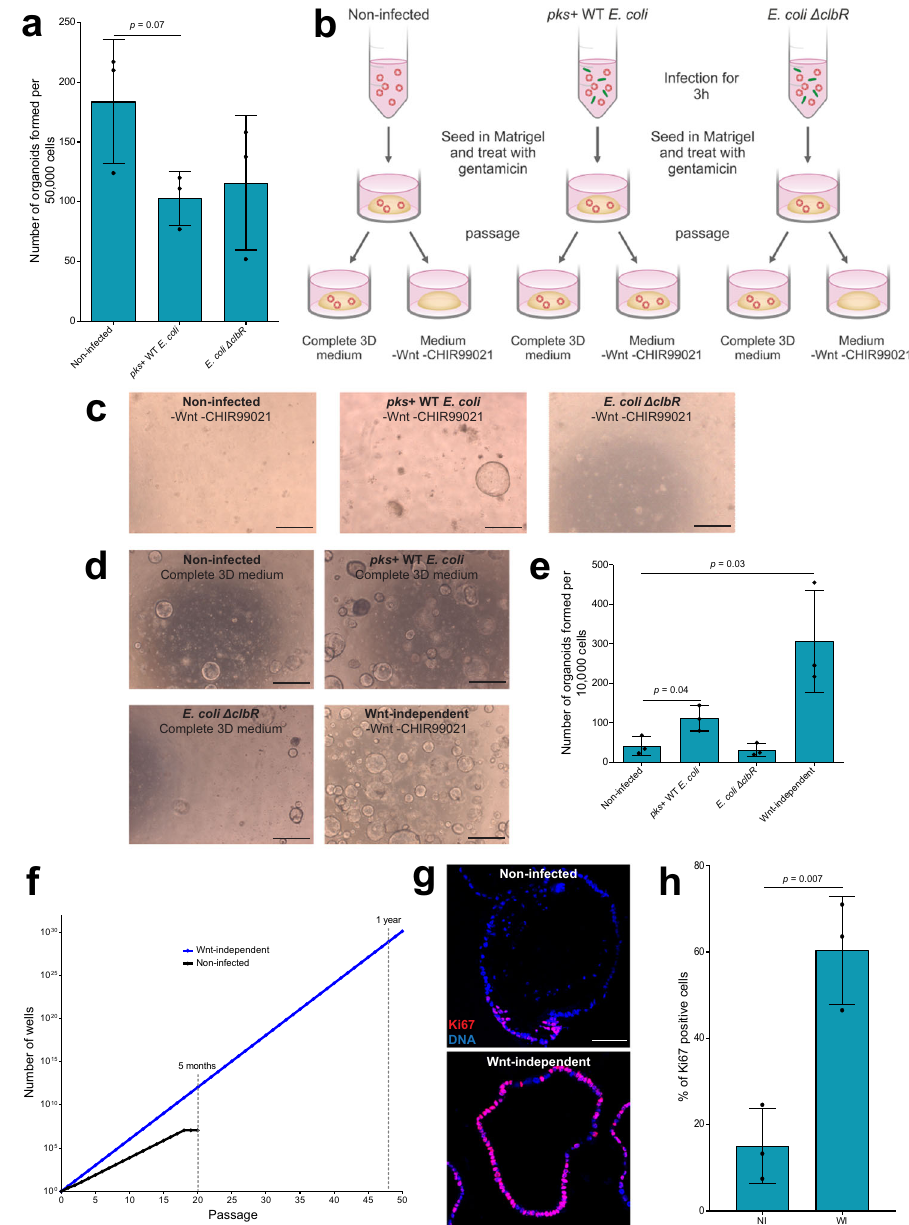
Fig. 2 Wnt-independent growth of organoids after infection with pks + E. coli . a Organoids formed after seeding 50,000 non-infected, pks + WT E. coli - infected, and E. coli Δ clbR -infected cells from three independent replicates. Data represent mean ± SD, p < 0.05, as calculated by two-sided unpaired Student ’ s t -test. b Scheme describing the infection of organoids. c Organoids grow without the addition of Wnt and CHIR99021 to the medium for the pks + WT E. coli- infected condition, but not for the non-infected or E. coli Δ clbR -infected conditions. Image representative of four independent replicates. Scale bars: 1 mm. d Organoids formed after seeding 10,000 cells in each condition. Image representative of three independent replicates. Scale bars: 1 mm. e Quanti fi cation of the number of organoids formed after seeding 10,000 cells in each condition from three replicates. Data represent mean ± SD, p < 0.05, as calculated by two-sided unpaired Student ’ s t -test. f Wnt-independent organoids have a higher splitting ratio and grow inde fi nitely when compared to non-infected organoids. Graph representative of four independent replicates. g Immuno fl uorescence staining for Ki67 (red) in non-infected organoids and Wnt-independent organoids. Hoechst (blue) stains for DNA. Image representative of three independent replicates. Scale bars: 100 μ m. h Quanti fi cation of the percentage of Ki67-positive cells from three replicates. Data represent mean ± SD, p < 0.05, as calculated by two-sided unpaired Student ’ s t -test. NI = non-infected and WI = Wnt-independent. Source data are provided as a Source Data fi